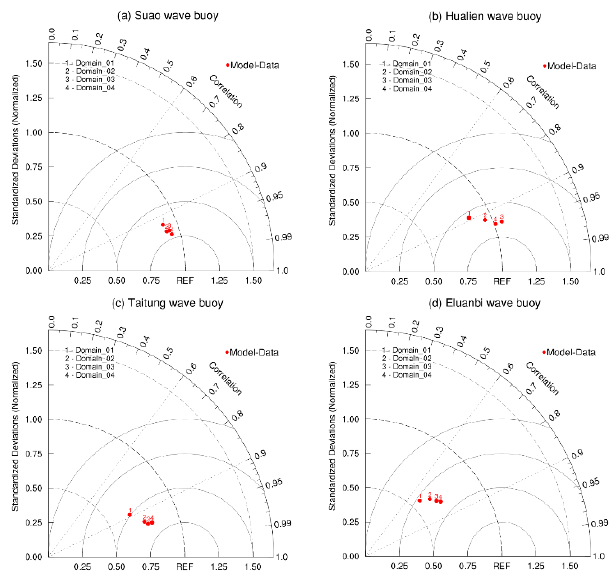
Figure 7. Taylor diagram of the relative bias, correlation coefficient, and normalized standard deviation patterns between the in situ observations and model simulations of significant wave height using ERA5 wind fields and the four computational domains for the ( a ) Suao, ( b ) Hualine, ( c ) Taitung, and ( d ) Eluanbi wave buoys.